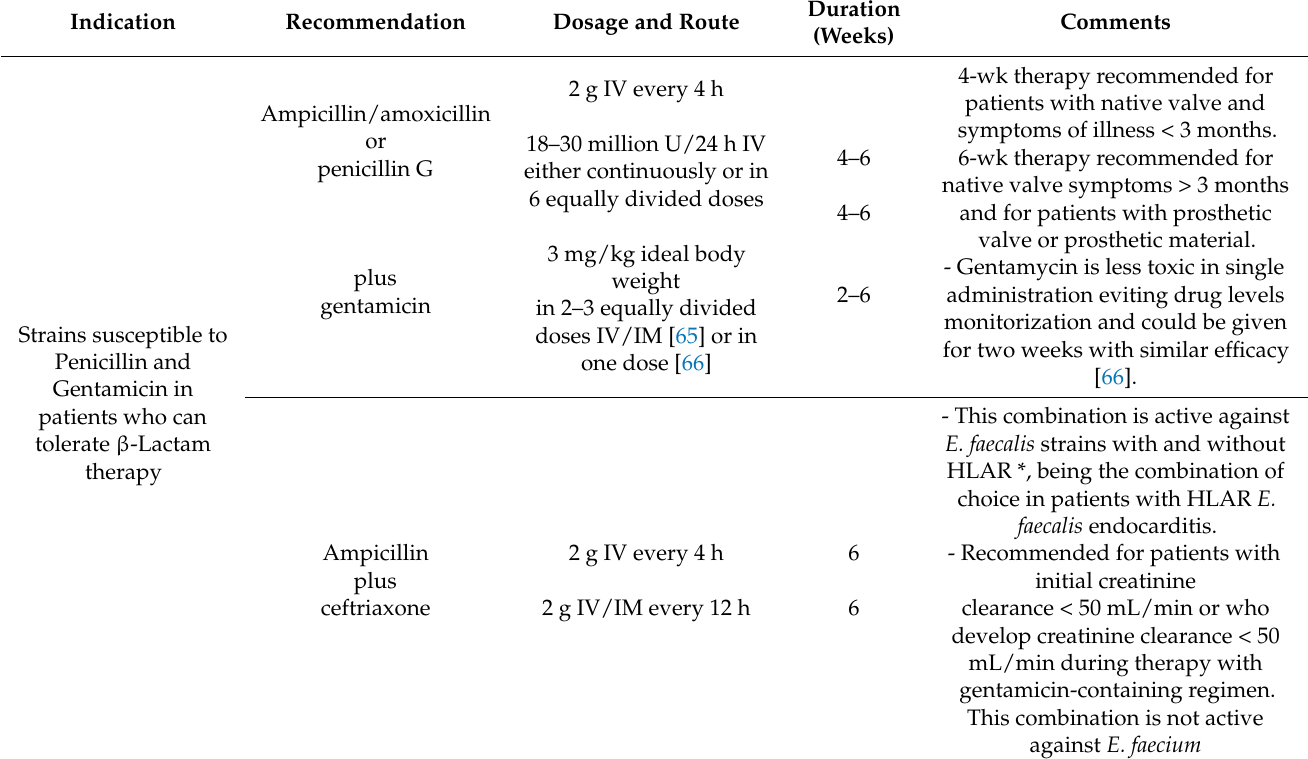
Table 3. Renal adjustments for antimicrobials are provided in Table 4. Table 2. American Heart Association [65] and European Society of Cardiology [66] guidelines for the treatment of Enterococcus infective